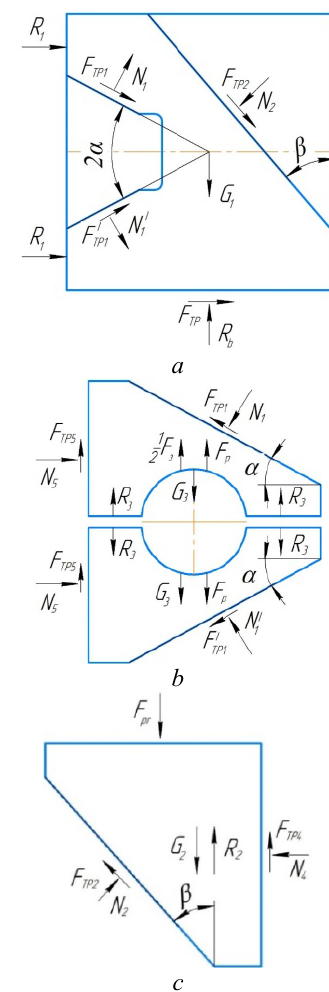
Figure 3. Forces acting on the main parts of the stamp